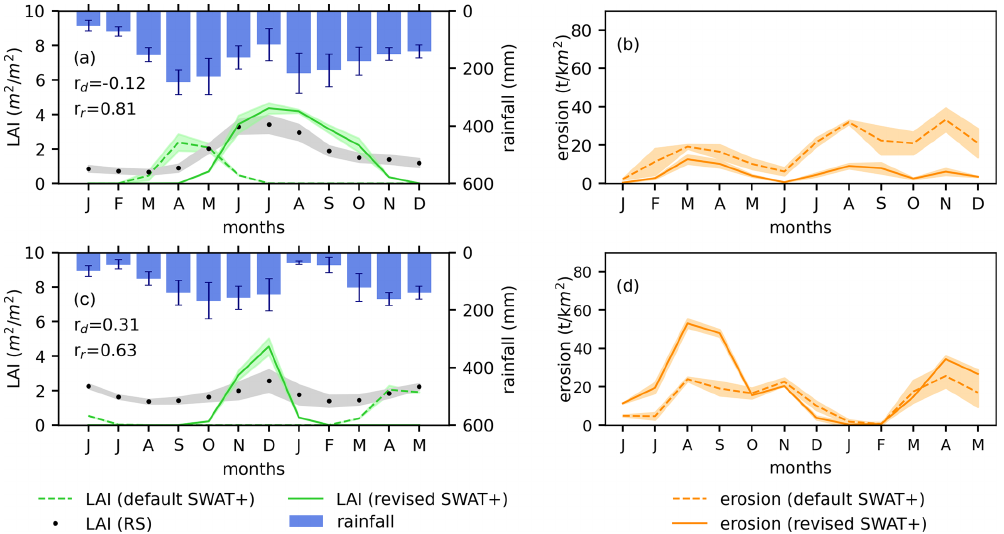
Figure A2. Monthly mean and standard deviation (bands) of (a, c) LAI and (b, d) erosion comparison for irrigated maize case 1 (irrigation during the dry growing season) and for irrigated maize case 2 (irrigation during the main wet growing season), respectively, in the Victoria Basin. The LAI correlation coefficients ( r d for the default SWAT + model and r r for the revised SWAT + model) are shown.